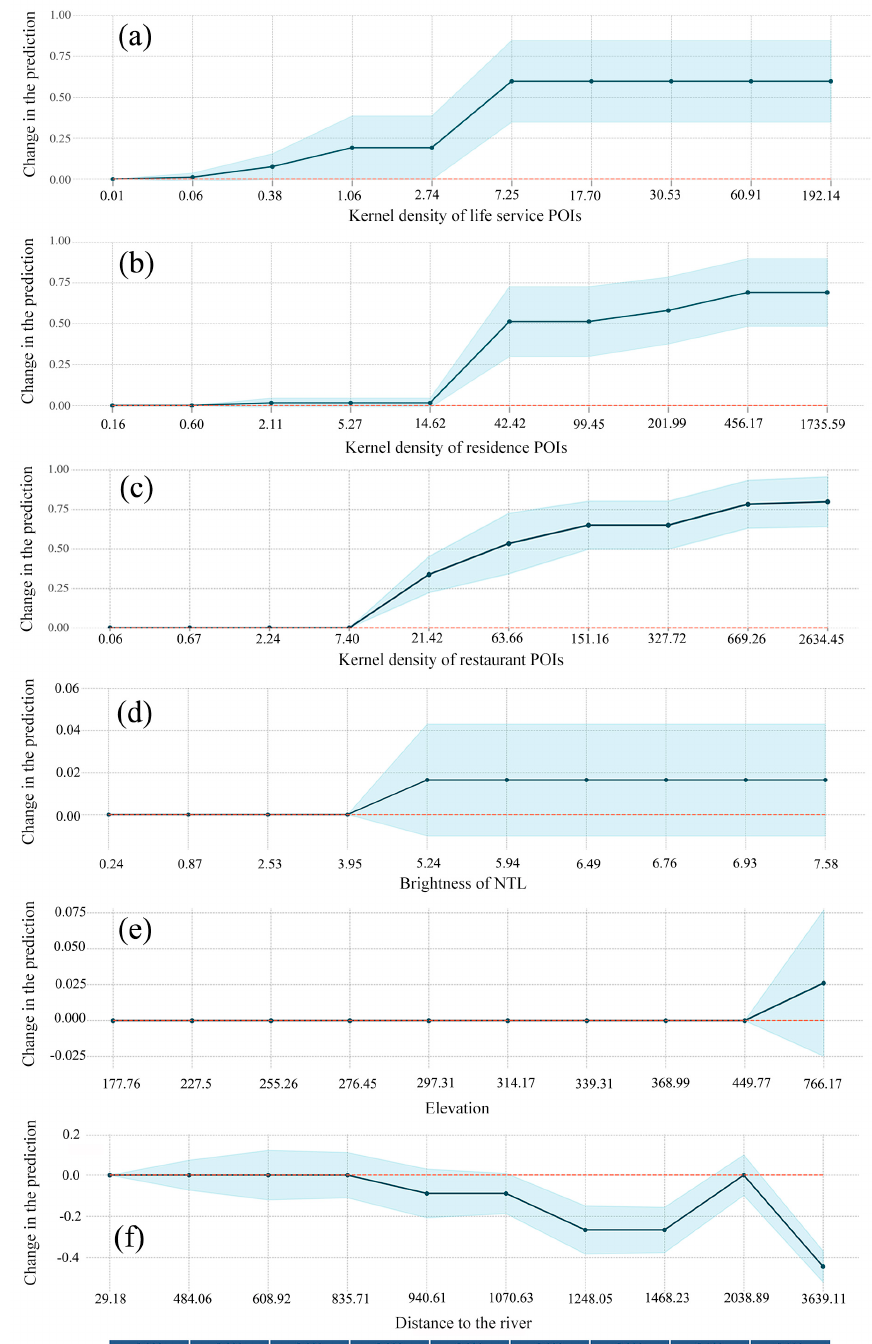
Figure 9. Partial dependency plots (PDP) for the features:( a ) the kernel density of life service points of interest (POIs), ( b ) the kernel density of residence POIs, ( c ) the kernel density of restaurant POIs, ( d ) the brightness of night time light (NTL), ( e ) elevation and ( f ) distance to the river in the random forest regression modelto estimate the population redistribution weight. Dark blue bar at the bottom indicates the deciles (11.1% quantiles) of the observed distribution of the continuous prediction features. The blue shaded area indicates the level of